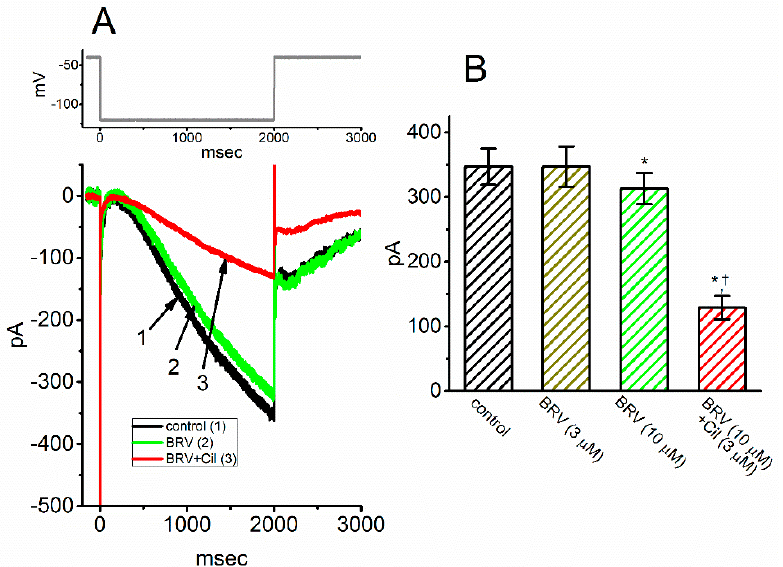
Figure 3. Mild inhibition of BRV on hyperpolarization-activated cationic current ( I h ) in GH 3 cells. The experiments were conducted in cells immersed in Ca 2+ -free Tyrode’s solution containing 1 µM tetrodotoxin, where the pipette was filled with a K + -containing solution comprising K-aspartate 130 mM, KCl 20 mM, MgCl 2 1 mM, Na 2 ATP 3 mM, Na 2 GTP 0.1 mM, EGTA 0.1 mM, and HEPES 5 mM adjusted to pH 7.2 with KOH. ( A ) Representative I h traces activated by a 2 s hyperpolarizing voltage pulse ranging from − 40 to − 120 mV (indicated in the upper part of the figure). (1): control, (2): 10 µM BRV, and (3): 10 µM BRV plus 3 µM cilobradine (Cil); ( B ) Summary bar graph showing the effects of BRV and BRV plus cilobradine (Cil) in hyperpolarization-activated I h (mean ± SEM; n = 8). The current amplitude was measured at the endpoint of a 2 s hyperpolarizing pulse ranging from − 40 to − 120 mV. * indicates significantly different from control ( p < 0.05) and † indicates signficantly different from BRV (10 mM) alone group ( p < 0.05).